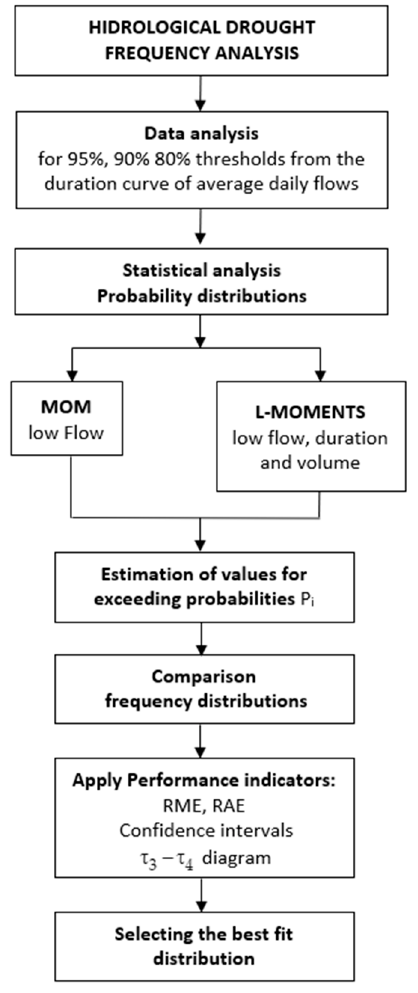
Figure 3. Methodological approach.